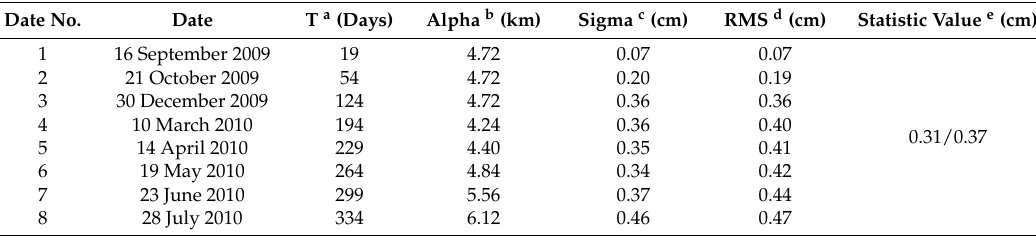
Table 1. Observation data used in this study.